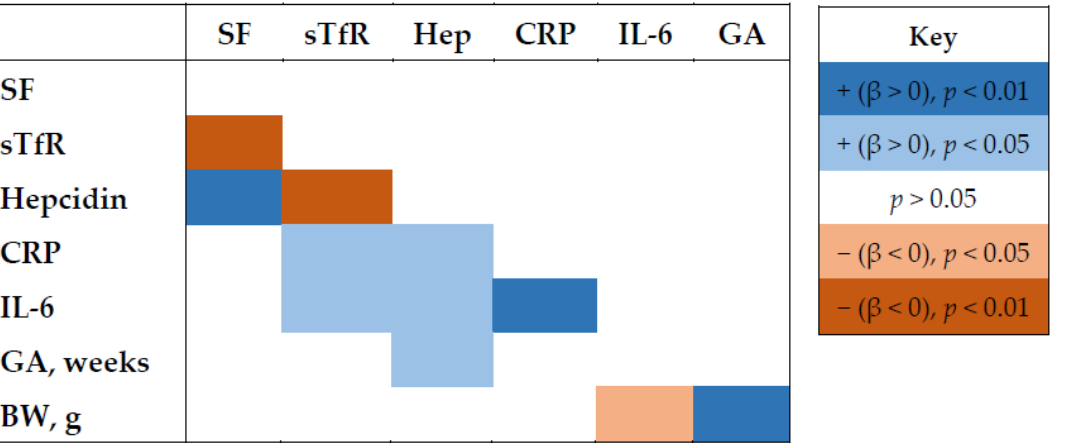
Figure 2. Associations among log-transformed iron and inflammation biomarkers, gestational age, and birth weight. Direction and strength of associations are indicated by color and intensity (see